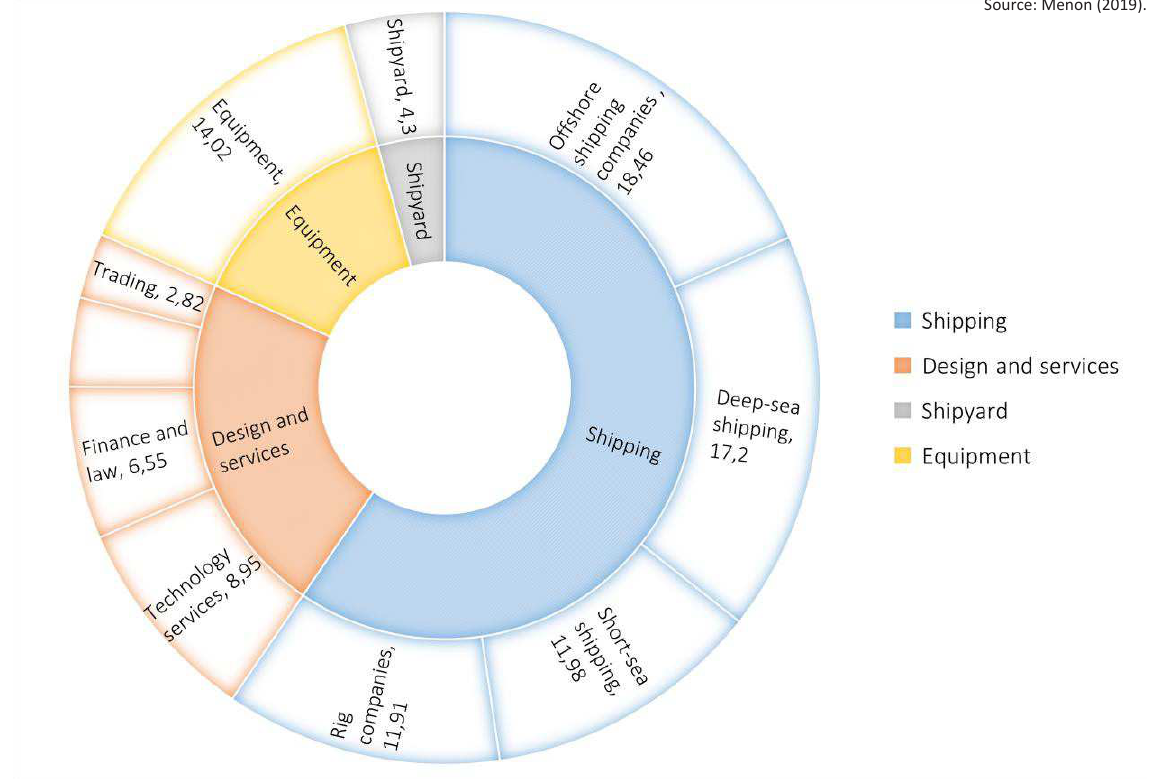
Figure 4. Value creation in main groups and subgroups in 2016 (numbers in billion NOK)